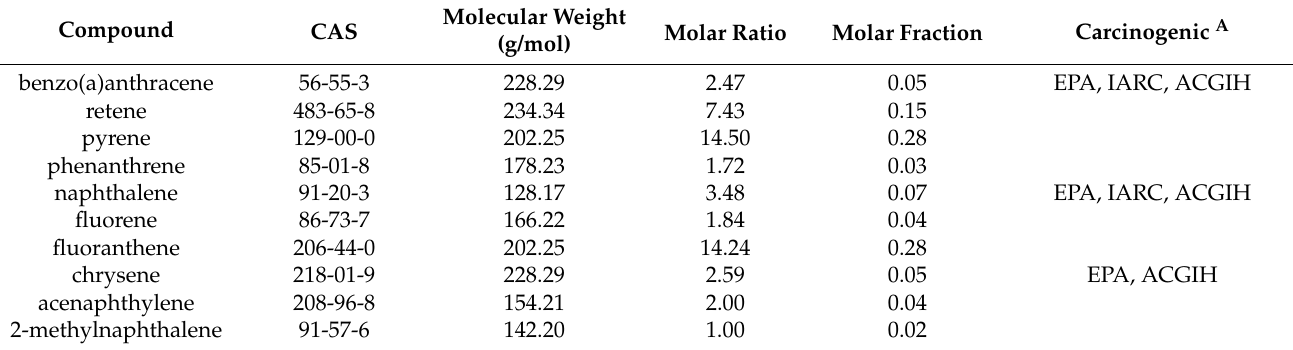
Table 1. Polycyclic aromatic hydrocarbons (PAHs) found in Supermix-10. Reported molar ratios are normalized to 2-methylnapthalene, the lowest abundant PAH in the